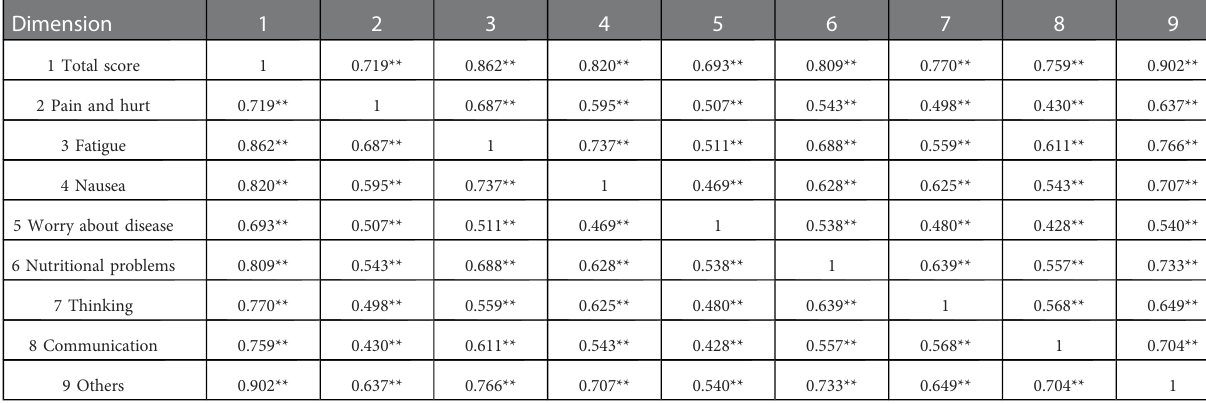
TABLE 8 Correlation between total score of the PedsQL ™ stem cell transplant module and each dimension for parent proxy-report.